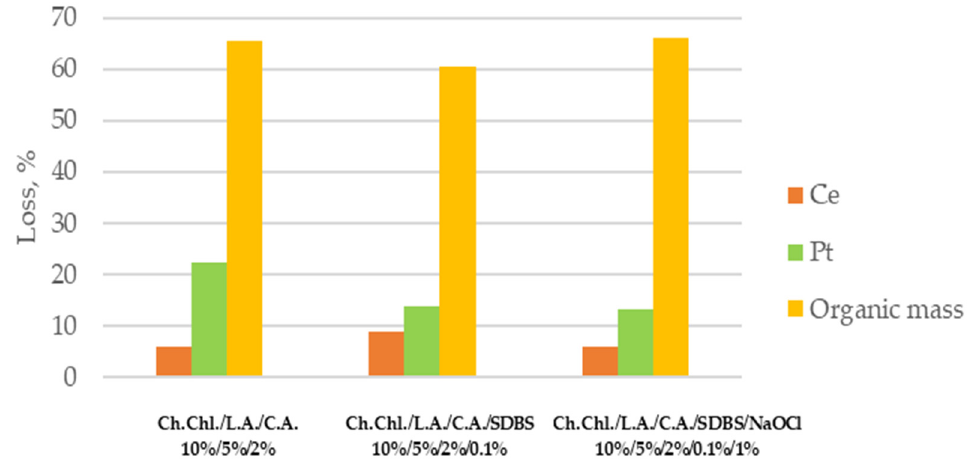
Figure 2. Organic mass, Ce, and Pt loss % of c-DPF for various reagents solutions.